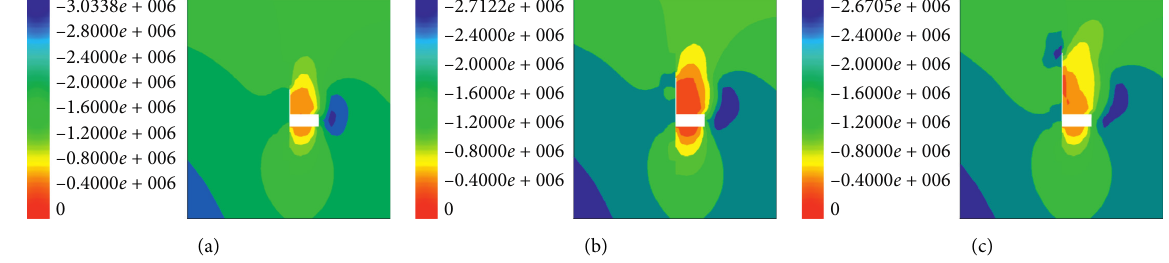
Figure 8: Vertical stress diagram of different cutting heights. (a) 4m. (b) 6m. (c) 10m.